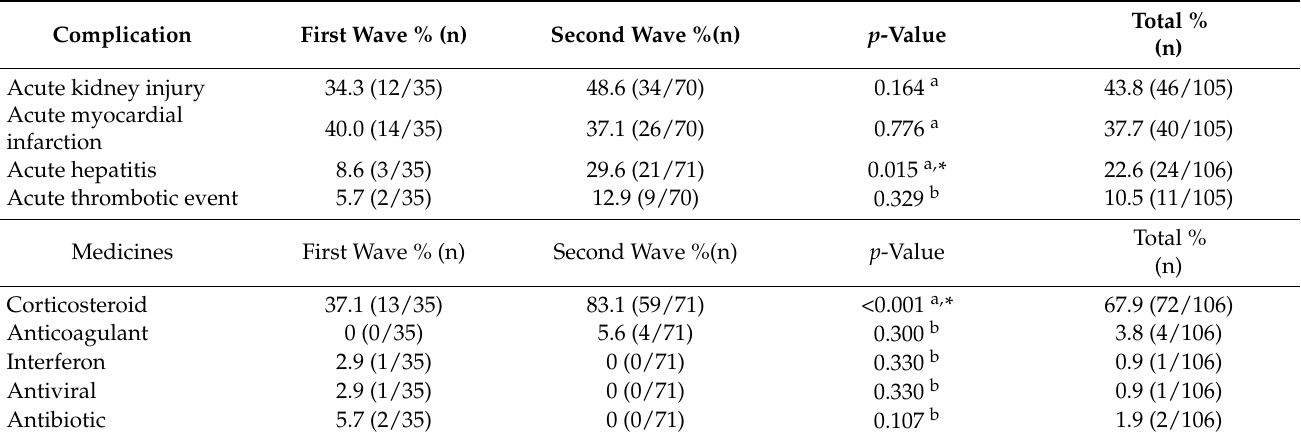
Table 9. Comparison of the complications and therapies used for COVID-19 during the two pandemic